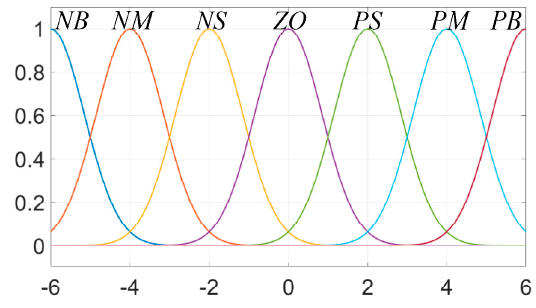
Figure 9. Affiliation function of the fuzzy PID controller.